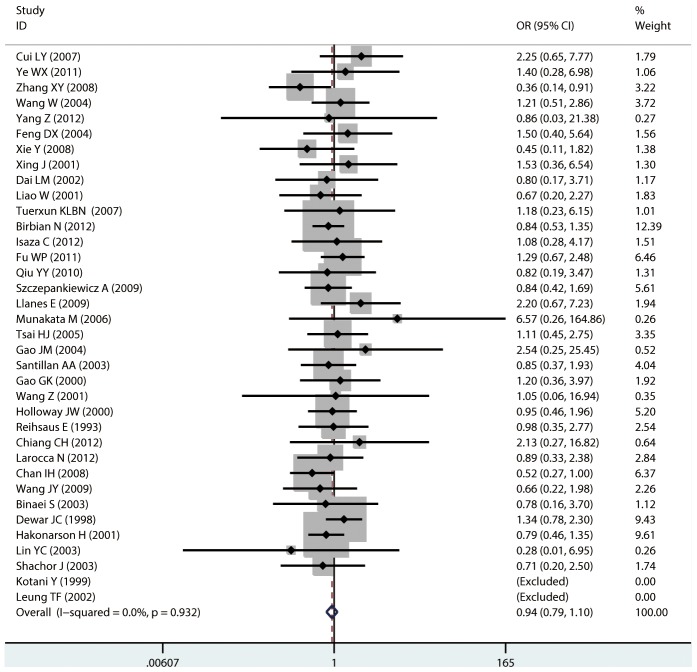
Forest plots of the association between the Gln27Glu (rs1042714) polymorphism and risk of asthma in homozygote genotype comparison.